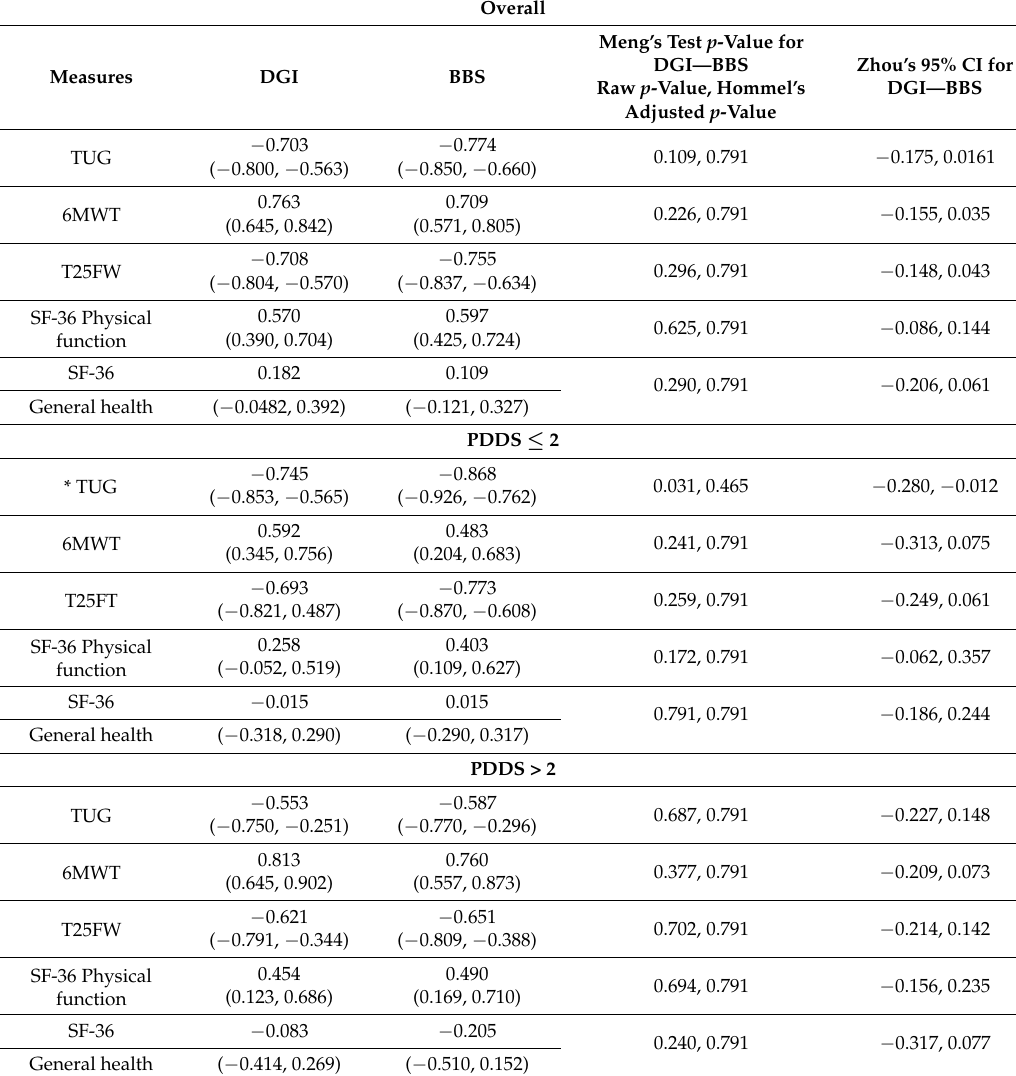
Table 3. Partial correlations with 95% confidence intervals (Spearman partial correlation). Covariates include age, sex, race, BMI, and